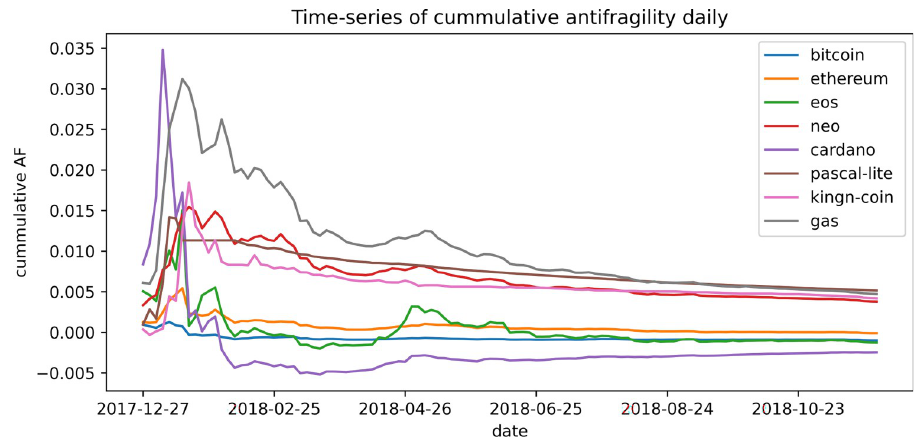
Fig 15. Cumulative mean of antifragility of few assets. The x- axes shows the date and the y- axis the cumulative antifragility measure. The figure shows a daily evolution of a selected set of cryptocurrencies for one year.